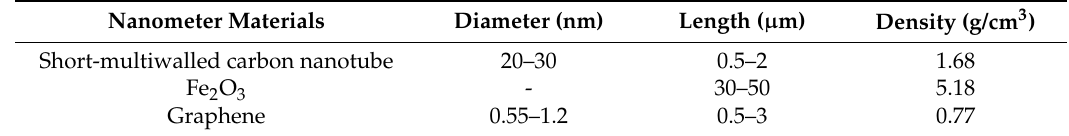
Table 2. Different kinds of nanoparticles used in the present